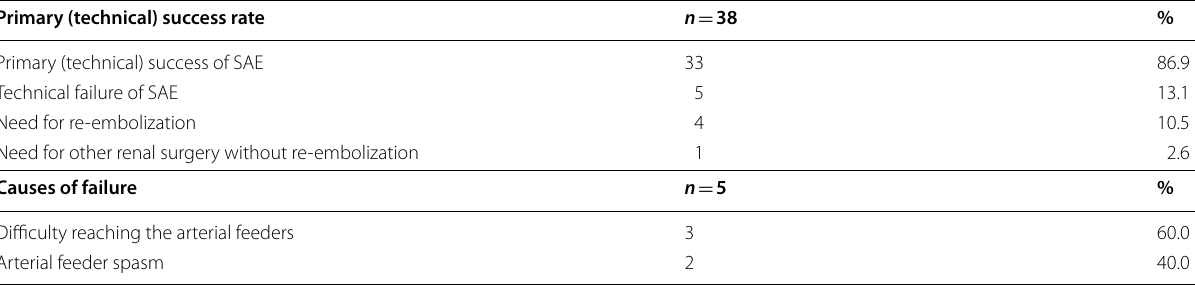
Table 3 Primary (technical) success rate